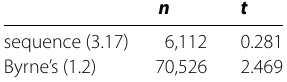
Table 4 (cid:2) = 10 –10 , P = 10, M = 5, N =